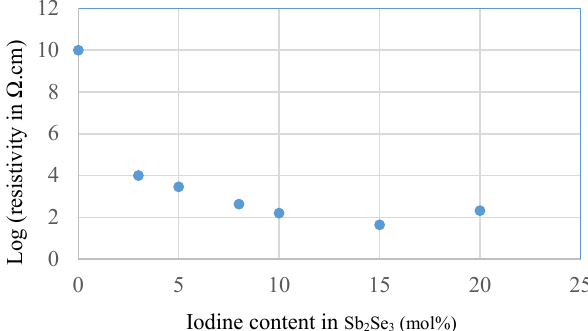
Fig. 4. Resistivity as function of iodine doping in Sb 2 Se